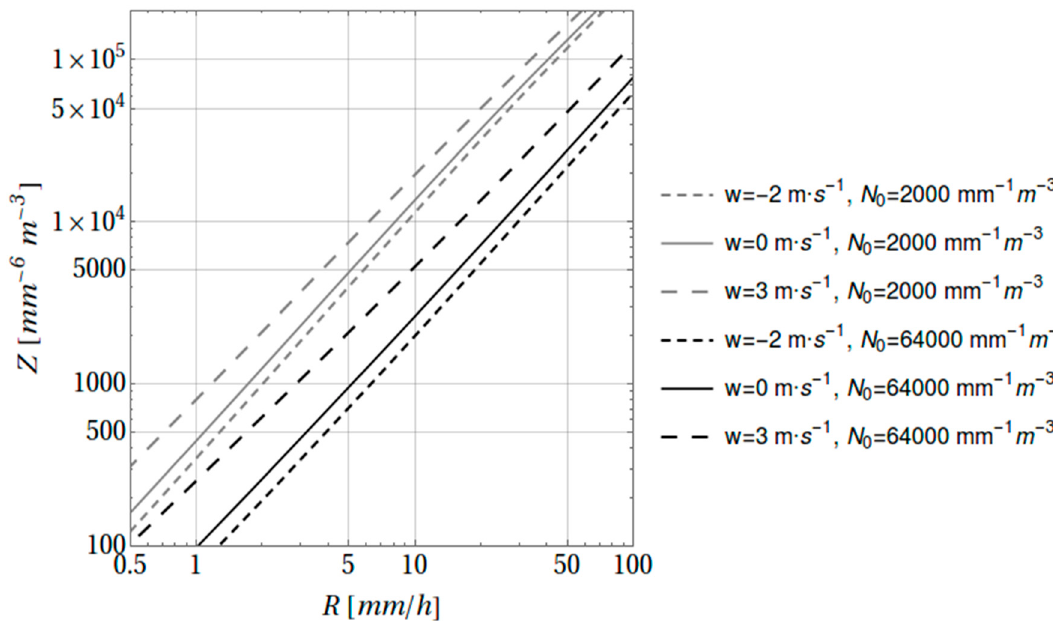
Figure 8. Z - R curves generated by FCM-DSD model with β = 0.9 and w 0 = 0.